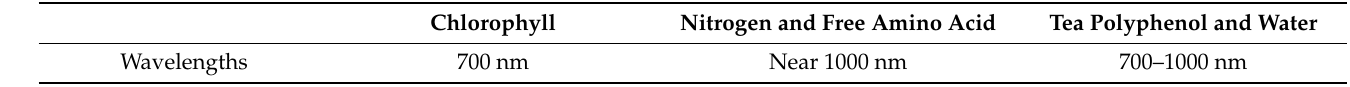
Table 4. Relationship between wavelength and leaf ingredients.